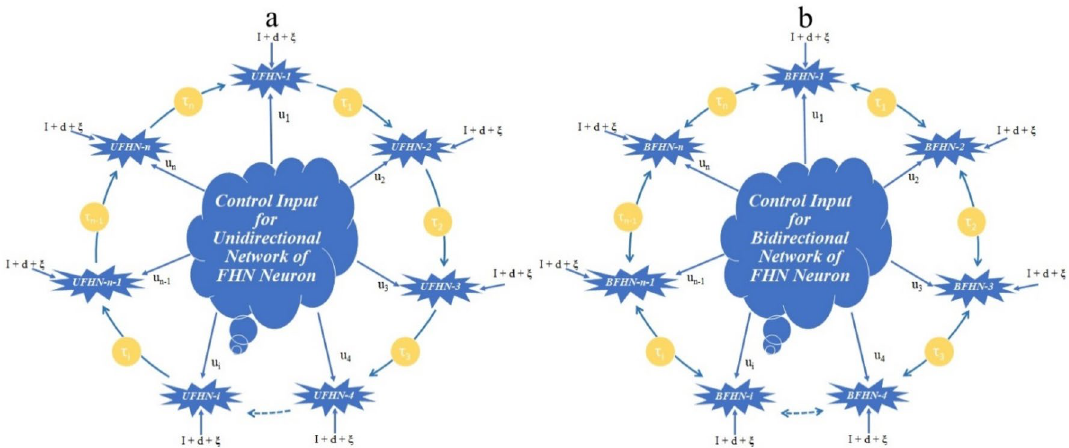
Figure 1. Schematic diagram of ring-structured delayed FHN neuronal networks. ( a ) Unidirectional coupling. ( b ) Bidirectional